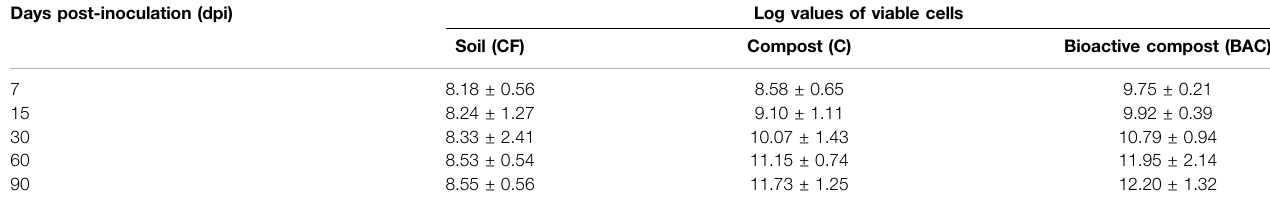
TABLE 8 | Effect of bioactive compost on total viable bacterial population. Days post-inoculation